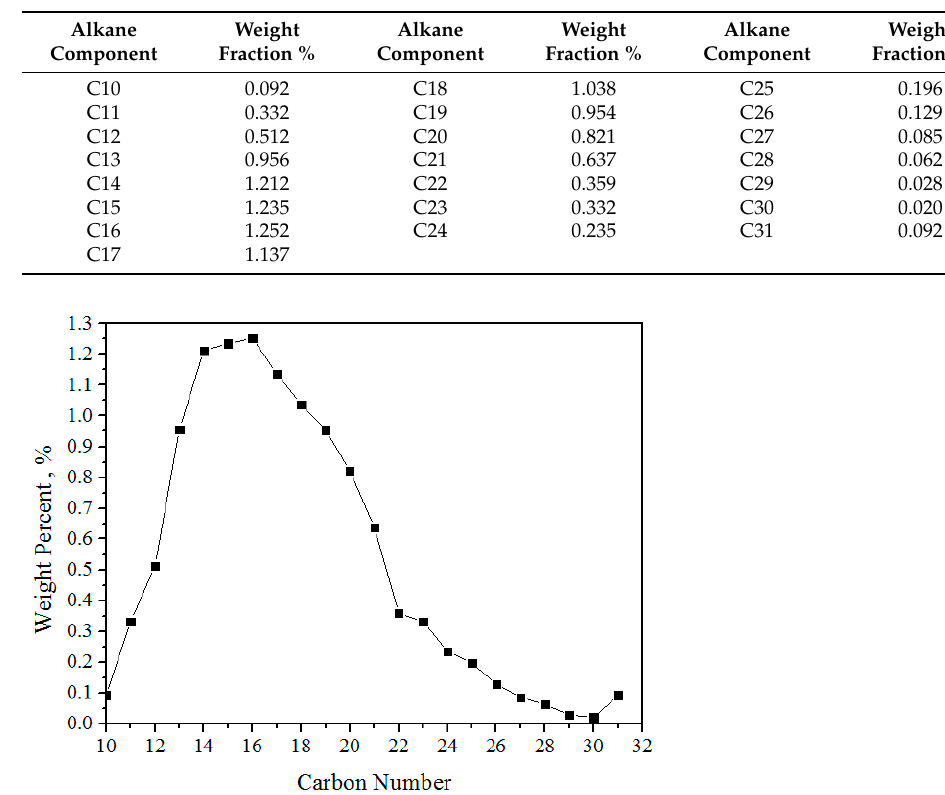
Figure 14. The paraffin distribution of 0# diesel. The mass fraction of solid wax crystals precipitated from 0# diesel oil at different gas chromatography, as shown in Table 2 and Figure 15. Table 2. Wax crystals precipitated from 0# diesel oil at different temperatures. Temperature, °C